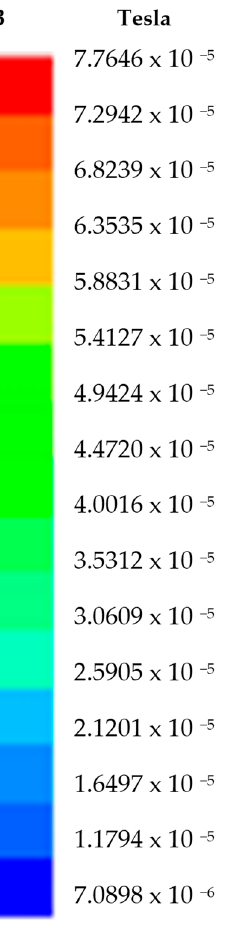
Figure 7. System efficiency and frequency from ANSYS Simplorer. Table 2. The circuit components values. C 1